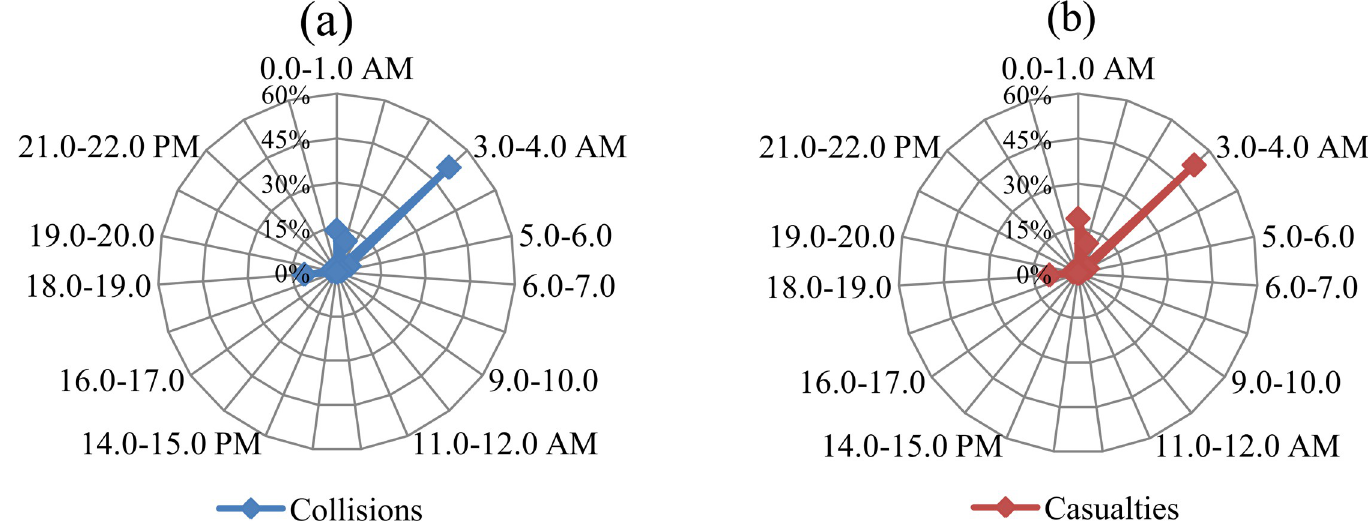
Fig 5. Hourly variations in the occurrences of (a) elephant-train collisions and (b) casualties.